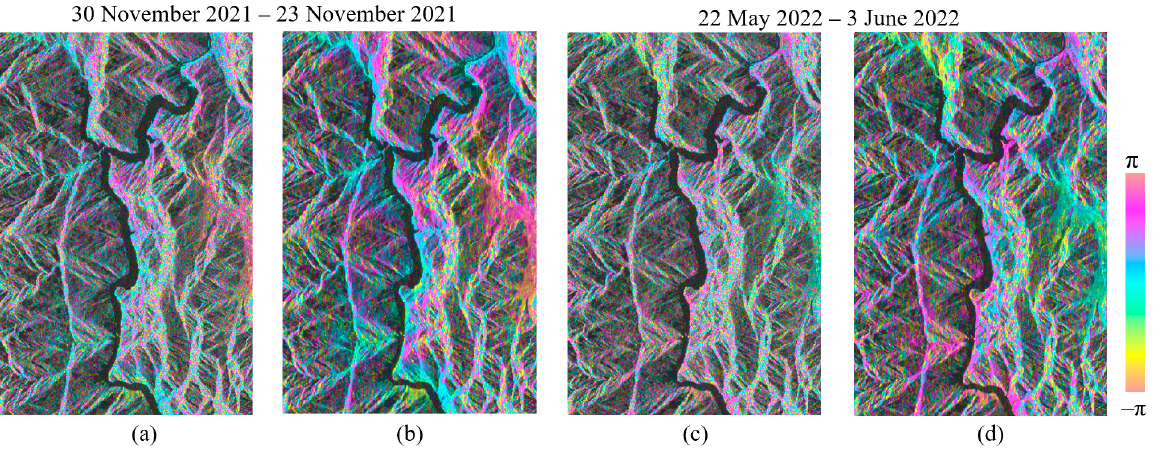
Figure 5. Spatiotemporal baseline of the Sentinel images with track 26 − 2.